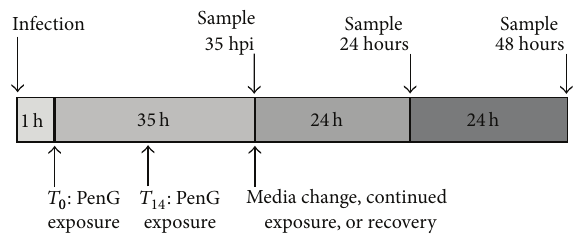
Figure 1: Study Design. The diagram illustrates infection and expo- sure beginning at 𝑇 0 , immediately postinfection, or at 𝑇 14 , 14 hours postinfection (hpi). HeLa cells were infected with Chlamydia peco- rum 1710S, exposed to penicillin G (PenG) in incubation medium, and incubated until 35 hpi, at which time samples were collected for analysis. For recovery experiments, incubation medium was changed for continued PenG exposure or discontinued exposure (recovery), and samples were subjected to 24 or 48 hours (h) of additional incubation before sample